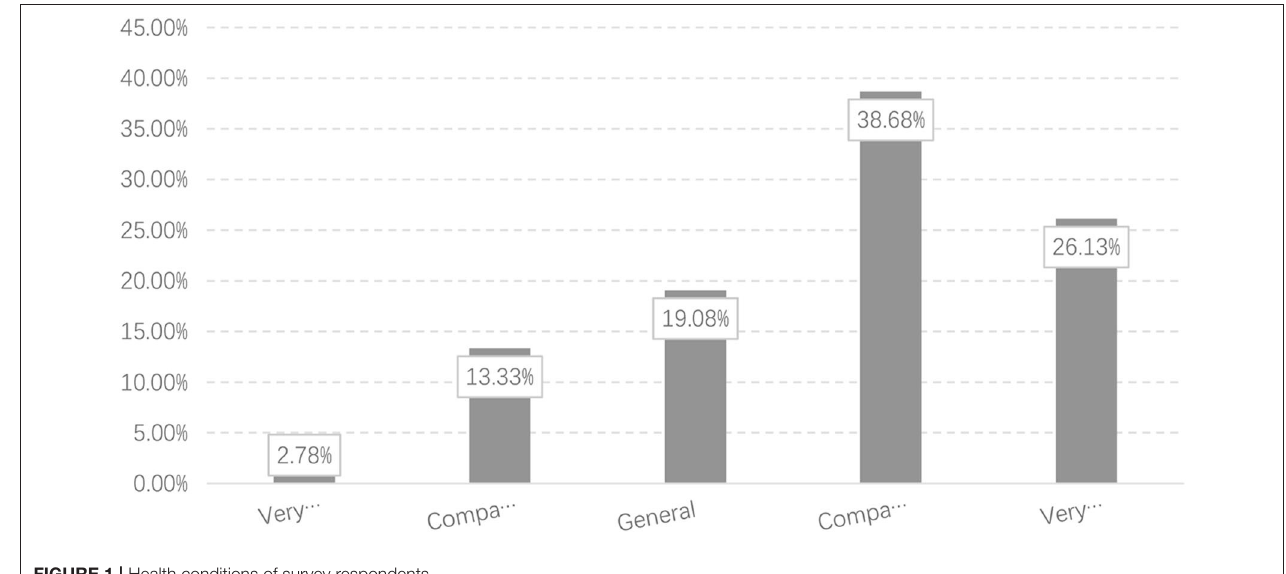
FIGURE 1 | Health conditions of survey respondents.